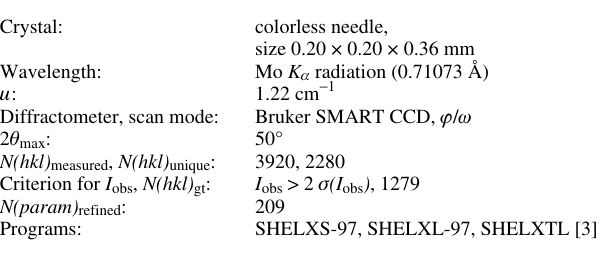
Table 1. Data collection and handling.